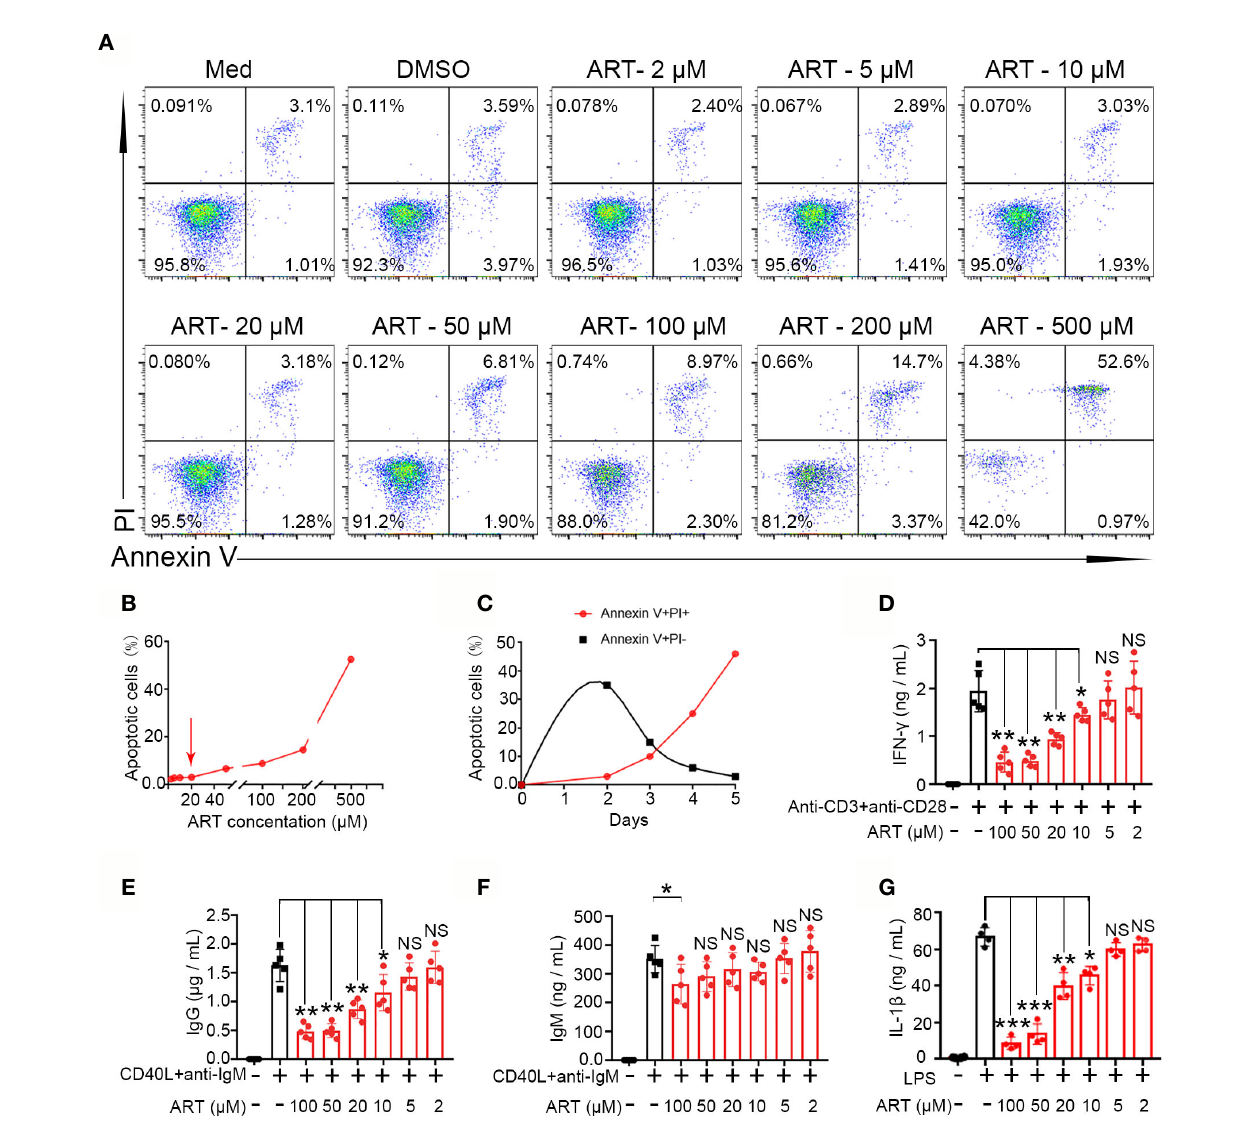
FIGURE 6 | Artemisinin (ART) inhibits T cell, B cell, and macrophage differentiation and reduces cytokines secretion in vitro . (A, B) Effect of ART on cell apoptosis was assessed by PI staining. (C) The dynamics of cell death induced by ART (20 µM) were measured by PI and annexin V staining. (D) Puri fi ed CD3 + T cells from PBMCs were stimulated with or without anti-CD3 plus anti-CD28 (1 µg/ml) in the presence or absence of various concentrations (2 to 100 m M) of ART. The cell culture supernatants were collected at 48 h and the level of IFN- g was measured by ELISA (n = 5). (E, F) Puri fi ed CD19 + cells from PBMCs were stimulated with or without CD40L (1 m g/ml) plus anti-IgM (5 m g/ml) in the presence or absence of various concentrations (2 to 100 m M) of ART. The cell culture supernatants were collected at 9 days and the levels of IgG and IgM were measured by ELISA (n = 5). (G) Puri fi ed CD14 + T cells from PBMCs were stimulated with or without LPS (1 m g/ml) in the presence or absence of various concentrations (1 to 20 m M) of ART. The cell culture supernatants were collected at 48 h and the levels of IL-1 b were measured by ELISA (n = 5). Statistical results are shown as the mean ± SD. * P < 0.05; ** P < 0.01, ***P < 0.001. PI, propidium iodide; PBMC, peripheral blood mononuclear cell; ELISA, enzyme linked immunosorbent assay. NS, no signi fi